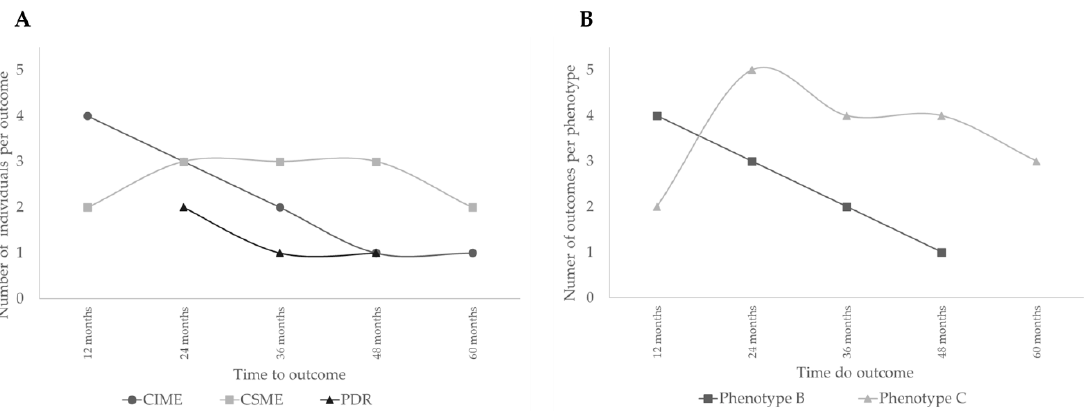
Figure 2. Analysis of the time to event of the development of outcomes. ( A ) Number of people with type 2 diabetes (T2D) developing di ff erent outcomes; ( B ) Number of people with T2D developing outcomes per